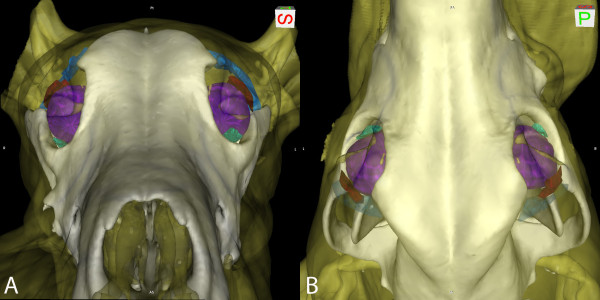
3D surface rendering of 1.25 mm postcontrast CT images demonstrating the relationship between the globe, the orbital ligament, the accessory lacrimal glands of the third eyelid (green), and the lacrimal glands (red). (A) View from rostral to caudal with right on the left side of the image, (B) view from dorsal with rostral at the top of the image.